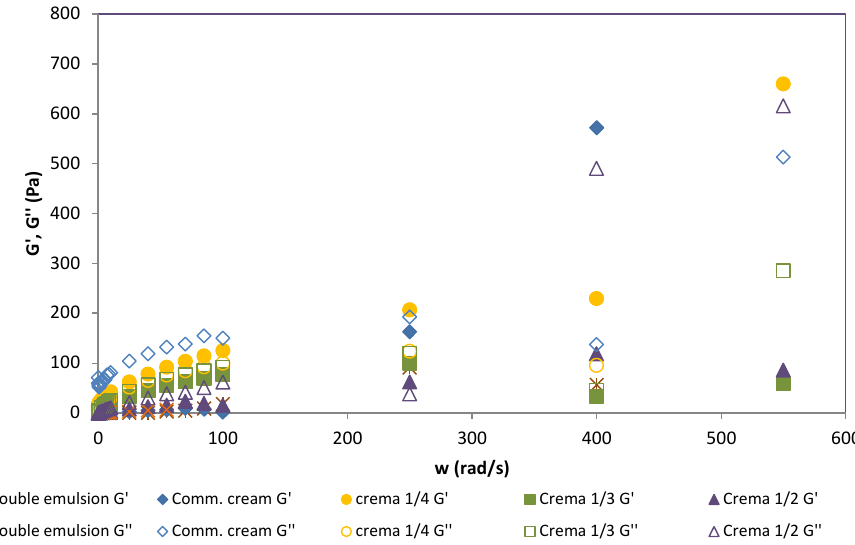
Figure 5. Frequency sweeps of the commercial cream and mixtures of the double emulsion, commercial cream and mixtures cream and double emulsion.